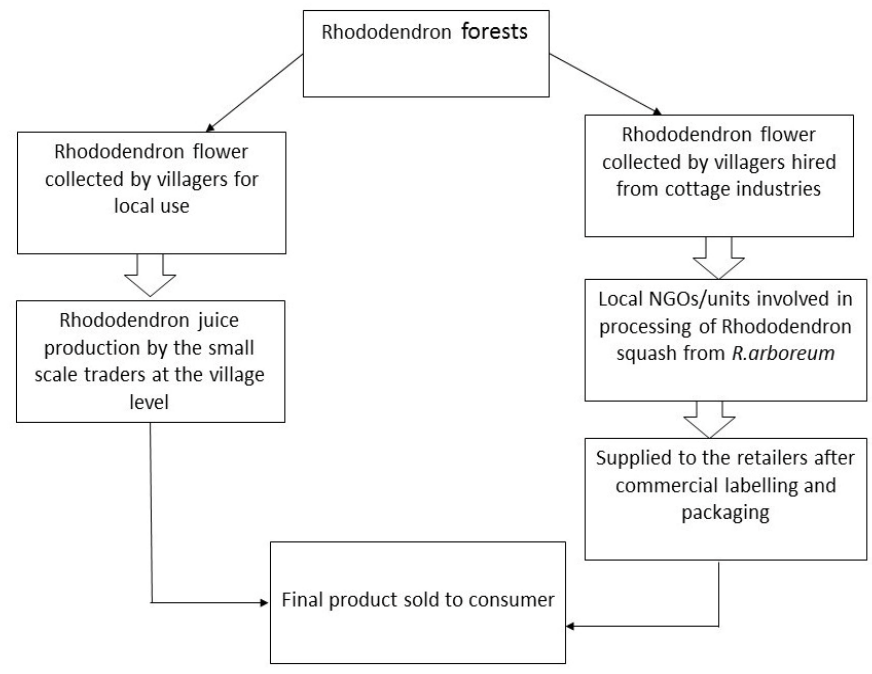
Figure 1. Flow-diagram of NTFP harvest in the study area.